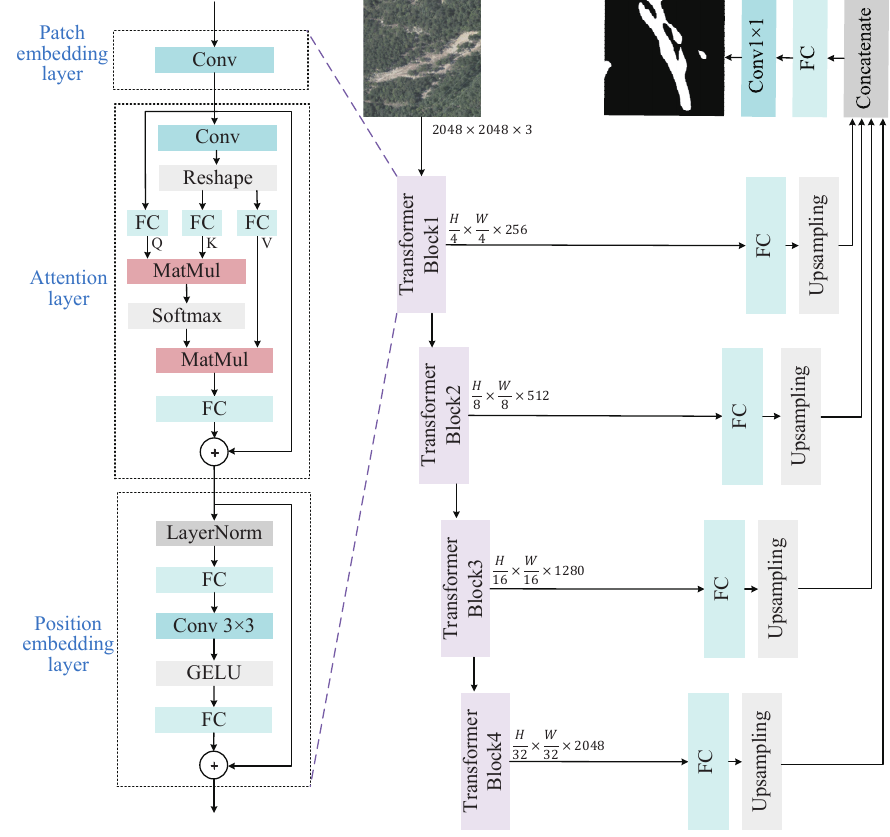
Figure 4. The architecture of